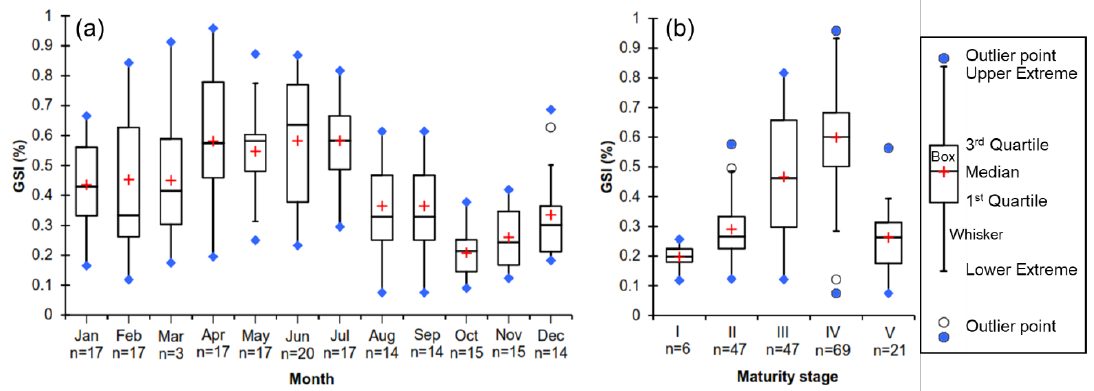
Figure 2. Gonadosomatic index (GSI) changes monthly ( a ) and different ovarian maturation stages ( b ) of blue tang fish (Box–Whisker diagram: +: Mean value; : Minimum or maximum value; p = 0.05).